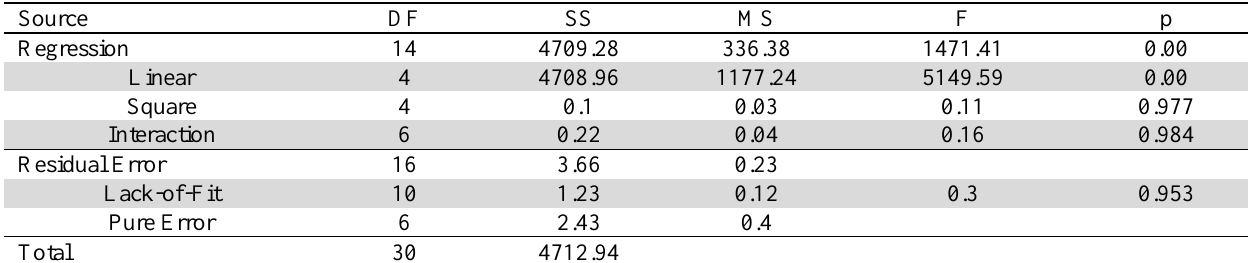
ANOVA table for thickness mean